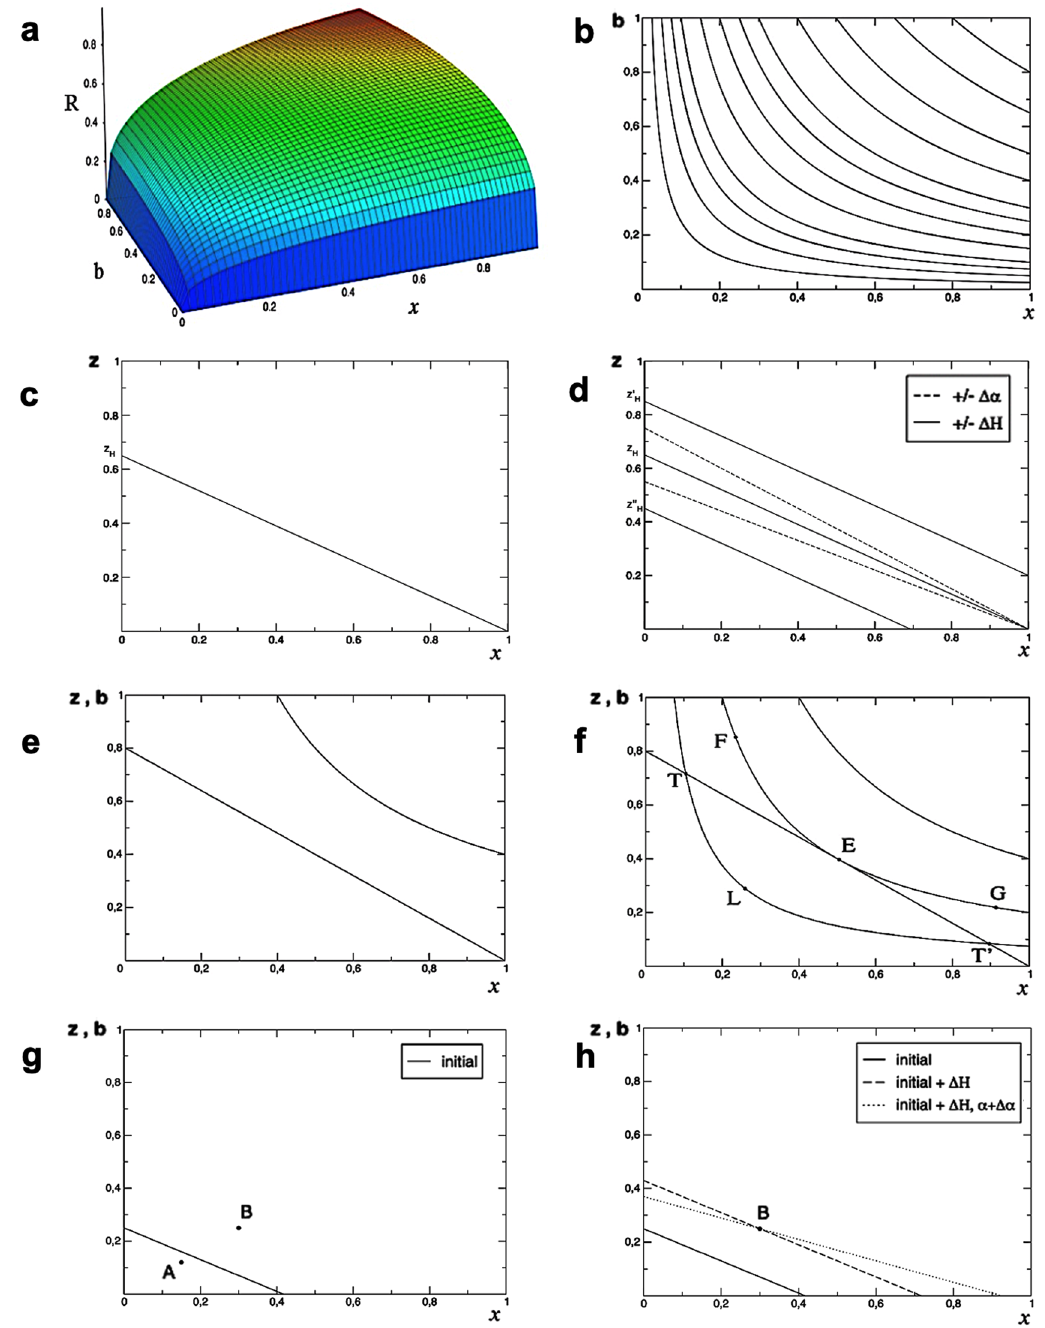
0.5 b 0.5 . ( c , d ) The carrying